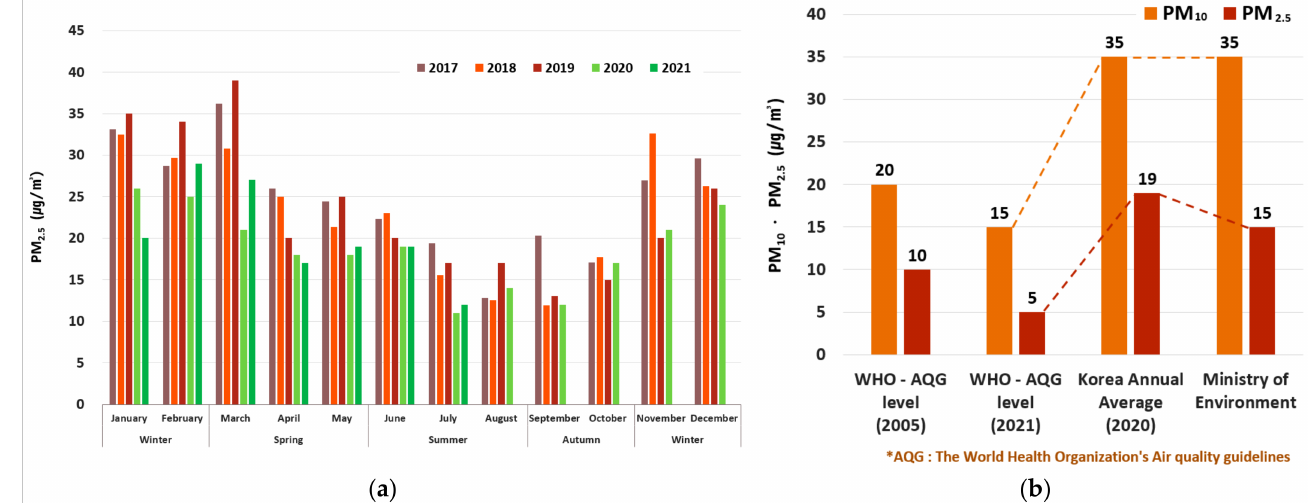
Figure 1. ( a ) Monthly national average concentrations of PM 2.5 in South Korea [3]. ( b ) PM 10 and PM 2.5 criteria recommended by the WHO and the Ministry of Environment and average concentrations of PM 10 and PM 2.5 in South Korea in 2020 [3–5].